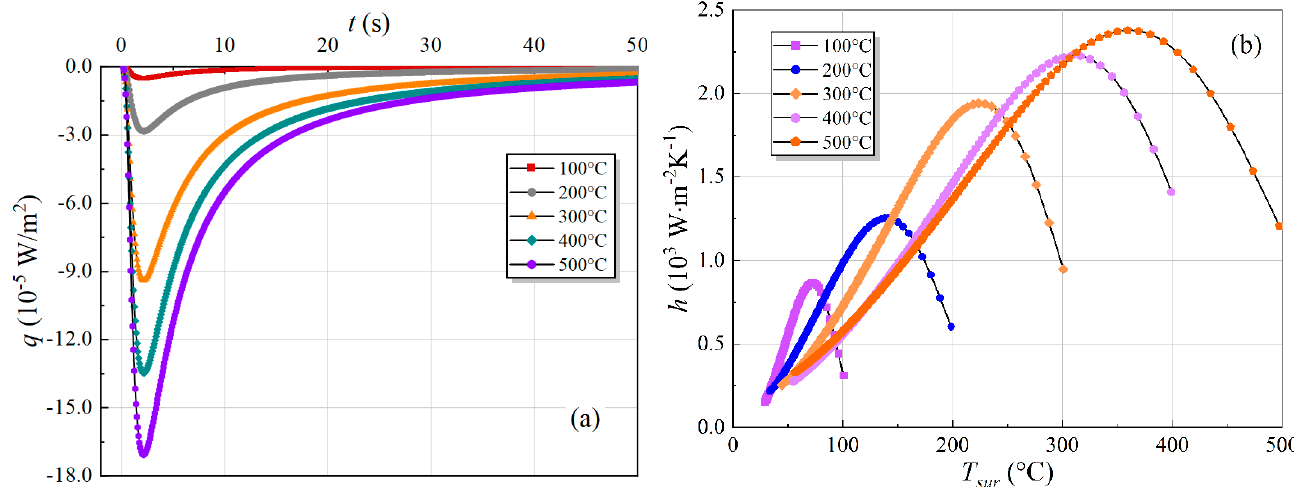
Figure 7. Heat conduction characteristics of high temperature granite subjected to water cooling: ( a ) heat flux on the sample surface; ( b ) relationship between the heat transfer coefficient and the surface temperature.